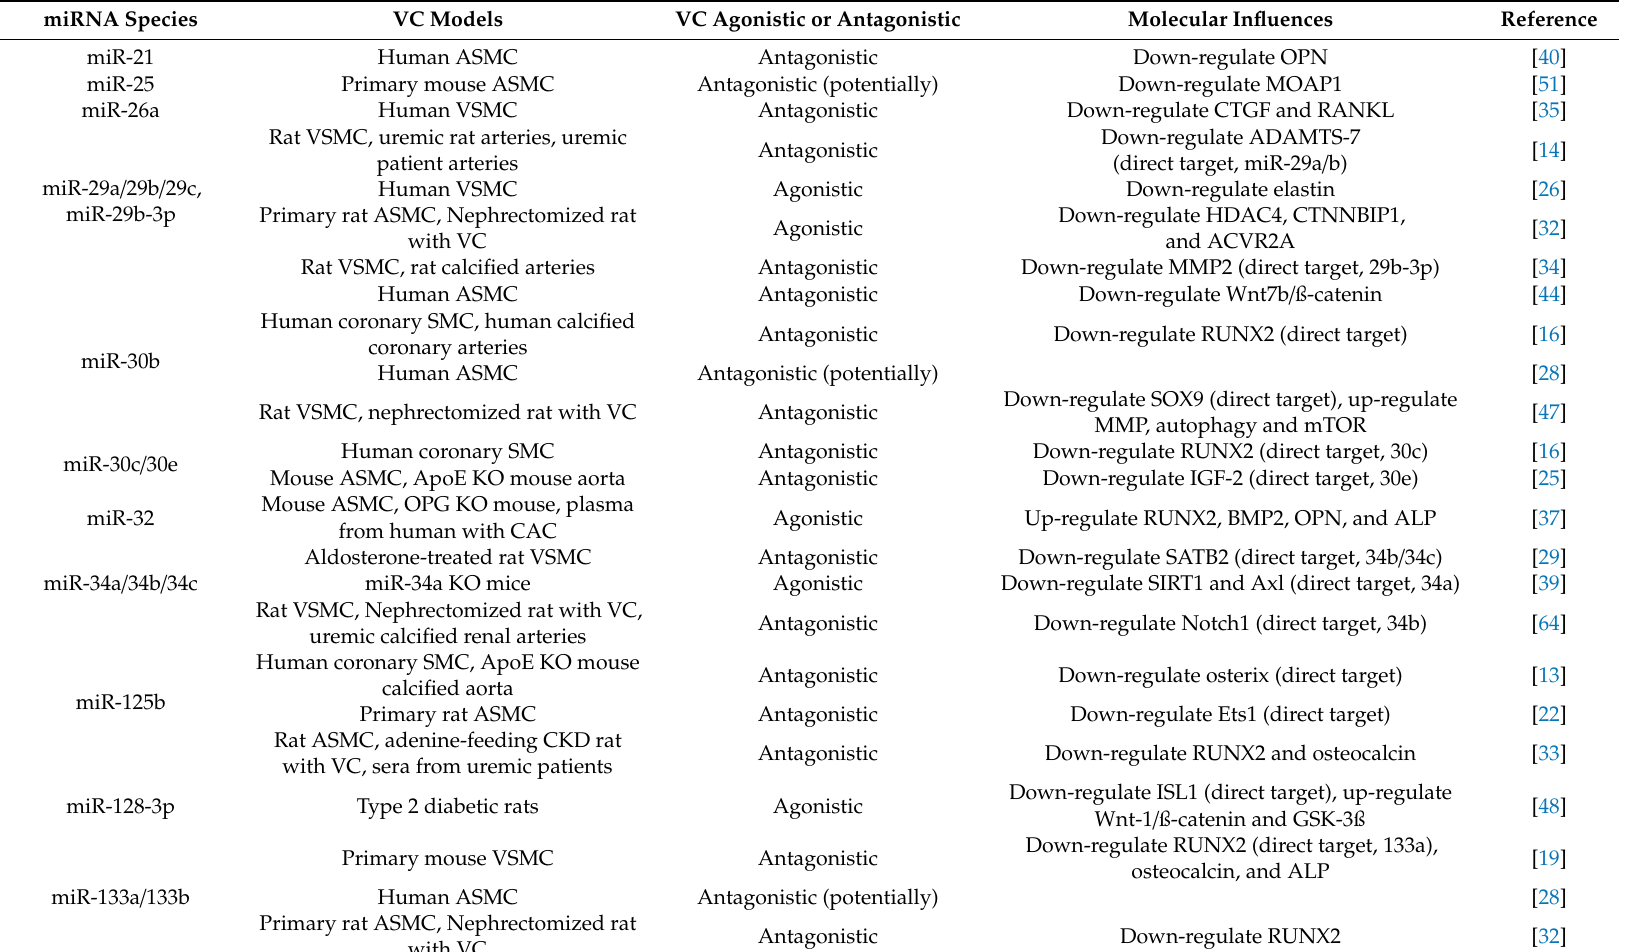
Table 1. MicroRNAs involved in